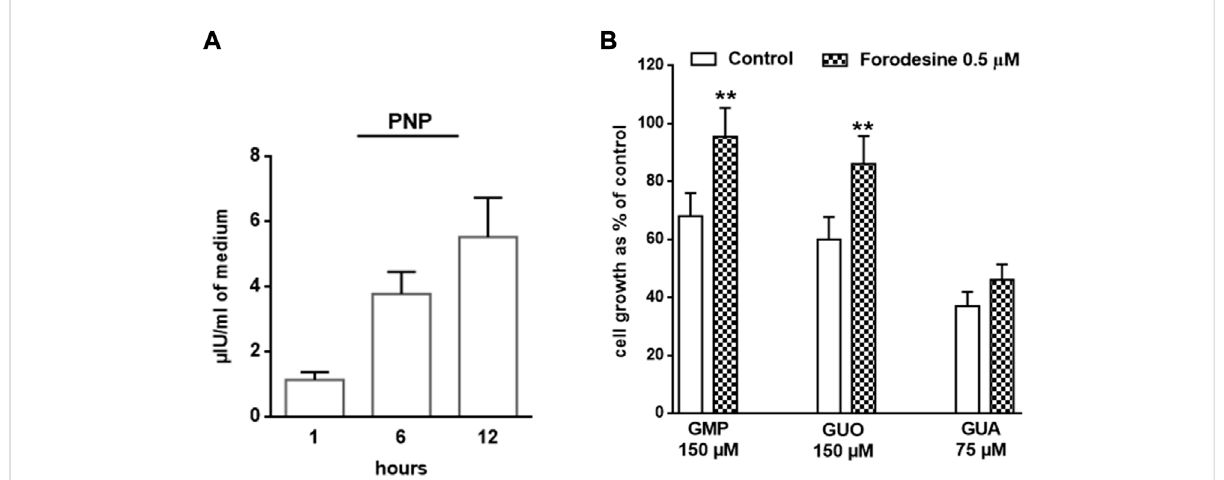
FIGURE 4 InvolvementofPNPactivityinGBPs-mediatedU87cellgrowthinhibition. (A) ActivityofPNPpresentintheU87cellculturemedium.Thegrowth medium of cells was collected at different times (i.e., 1, 6 and 12 h) and the PNP activity determined ( see Materials and Methods). (B) Impact of PNP inhibition on GBPs-dependent antiproliferative effect. U87 cells were exposed to GMP, GUO or GUA for 72 h, in the presence or absence (w/t) of forodesine, a PNP inhibitor. Results are expressed as the percentage of cell growth evaluated by the MTT assay in untreated cells (control). All values are the mean ± SD of 4 independent experiments. Statistical signi fi cance: ** p < 0.01 vs. cells not treated with forodesine (Student ’ s t